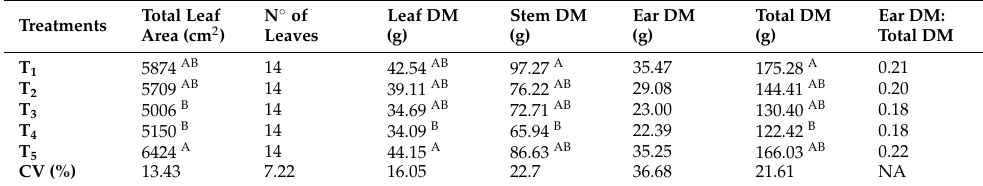
Table 7. Effect of fertilization treatments on the leaf morphology and dry matter of maize at the R5 dent stage. T 1 = basal application of the digestate from swine wastewater as total substitute (100%) for synthetic N; T 2 = foliar application of the digestate as total substitute (100%) for synthetic N; T 3 = basal application of the digestate as partial substitute (50%) for synthetic N; T 4 = foliar application of the digestate as partial substitute (50%) for synthetic N; T 5 = in-row broadcast of mineral fertilizer. The treatments are fully described in Table